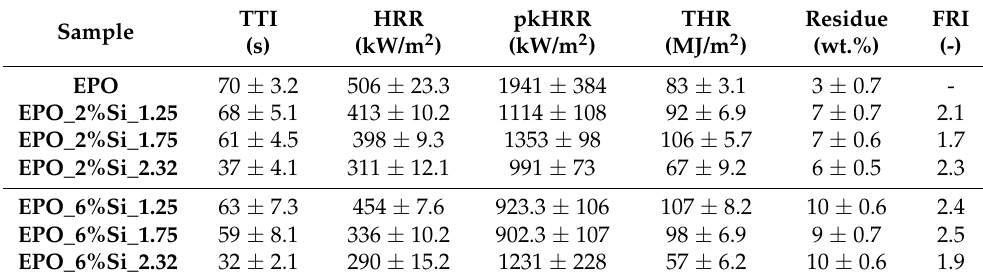
Table 3. Results (thermal parameters) from cone calorimetry tests (irradiative heat flux: 35 kW/m 2 ).